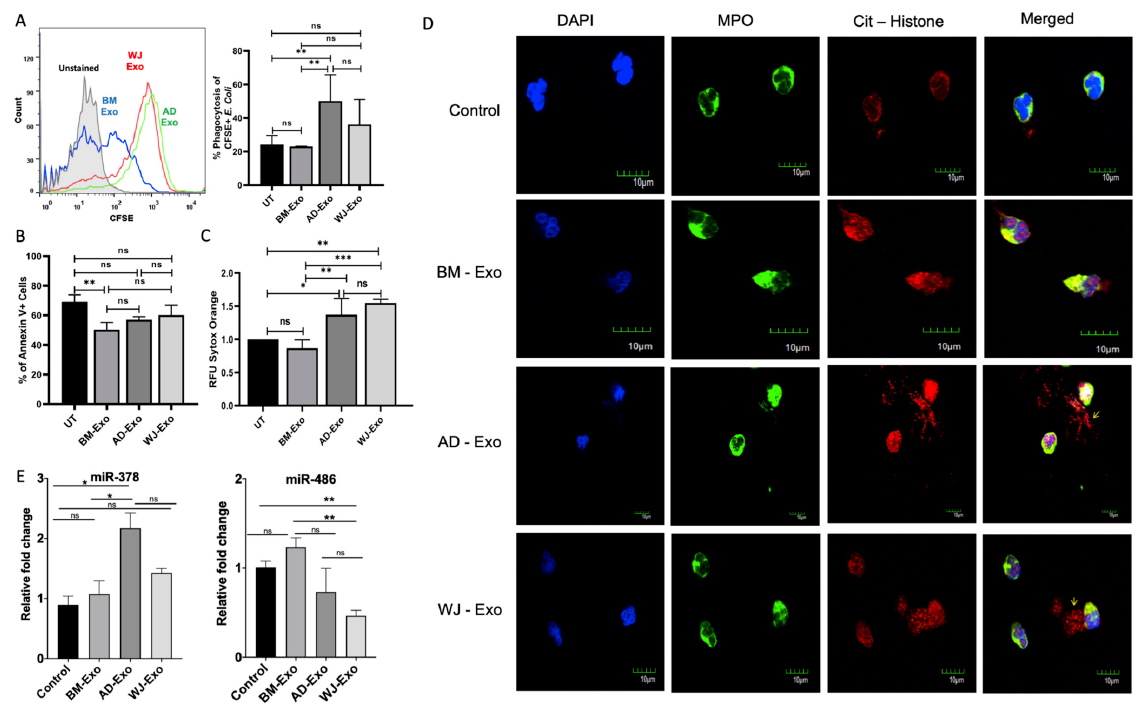
Figure 6. Effect of exosomes on neutrophil phagocytosis, apoptosis, and Neutrophil Extracellular trap formation. ( A ) A 30 ‐μ g equivalent exosomal protein for 8 h to study the effect on phagocytosis of E. coli cells. The percentage of CFSE ‐ positive cells is represented in the bar graph. Data are represented as Mean ± SE. ( B ) The effect of exosomes on apoptosis of neutrophils was studied using Annexin V, and Propidium Iodide was used to differentiate early apoptotic cells and necrotic cells. The percent of the early apoptotic population from three experiments is shown in the bar graph. Data are represented as mean ± SD. ( C ) Sytox assay was performed to inspect the extracellular DNA release after 6 h of treatment with exosomes. Data are represented as mean ± SEM, * p < 0.033, ** p < 0.002, and *** p < 0.001. ( D ) Extracellular NET formation by neutrophils upon exosomes’ incubation for 3 h. Cells were stained with anti ‐ MPO and anti ‐ Cit ‐ Histone antibodies and visualized under the confocal microscope. DAPI was used for nuclear staining. All cell images were captured with 40× objective. Scale bar = 10 μ m. Arrow indicates release of NET in extracellular space. ( E ) Expression of miR ‐ 378a and miR ‐ 486 in neutrophils incubated with exosomes for 24 h. Bar plots show the mean ± SD; * p < 0.01 and ** p < 0.005.; ns = non ‐ significant